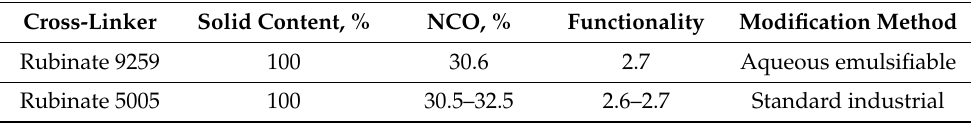
Table 1. Characteristics of polymer